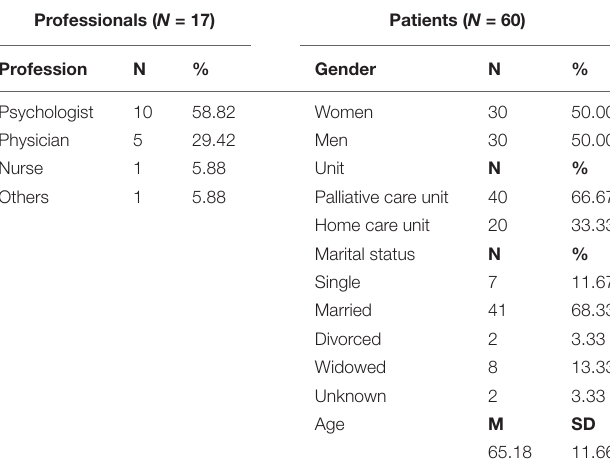
TABLE 2 | Professionals’ and patients’